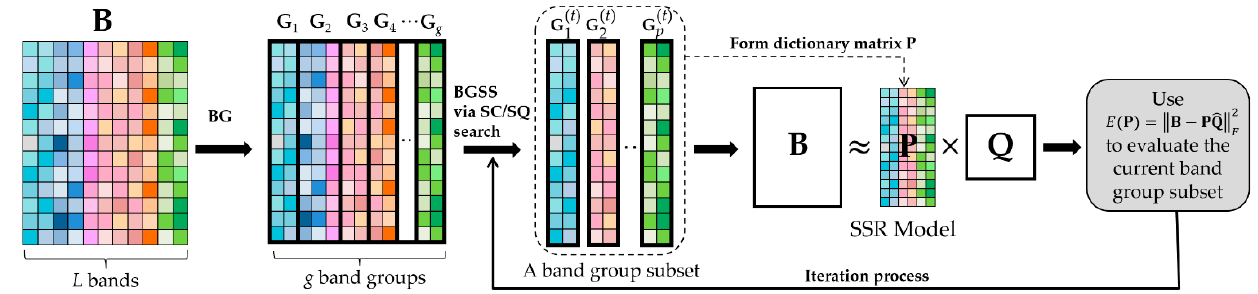
Figure 2. The mechanism of